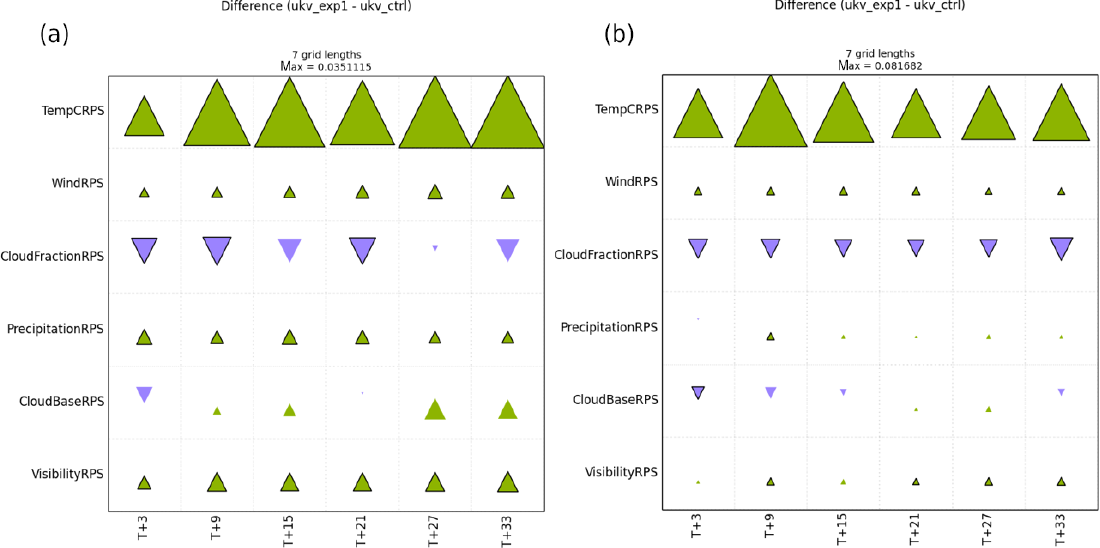
Figure 5. 3D-Var trials: RAL1-M vs. RAL0 HiRA summary scorecard at 10.5km (seven grid lengths) spatial scale for winter (a) and summer (b) . HiRA uses synoptic observations (see Sect. 5).